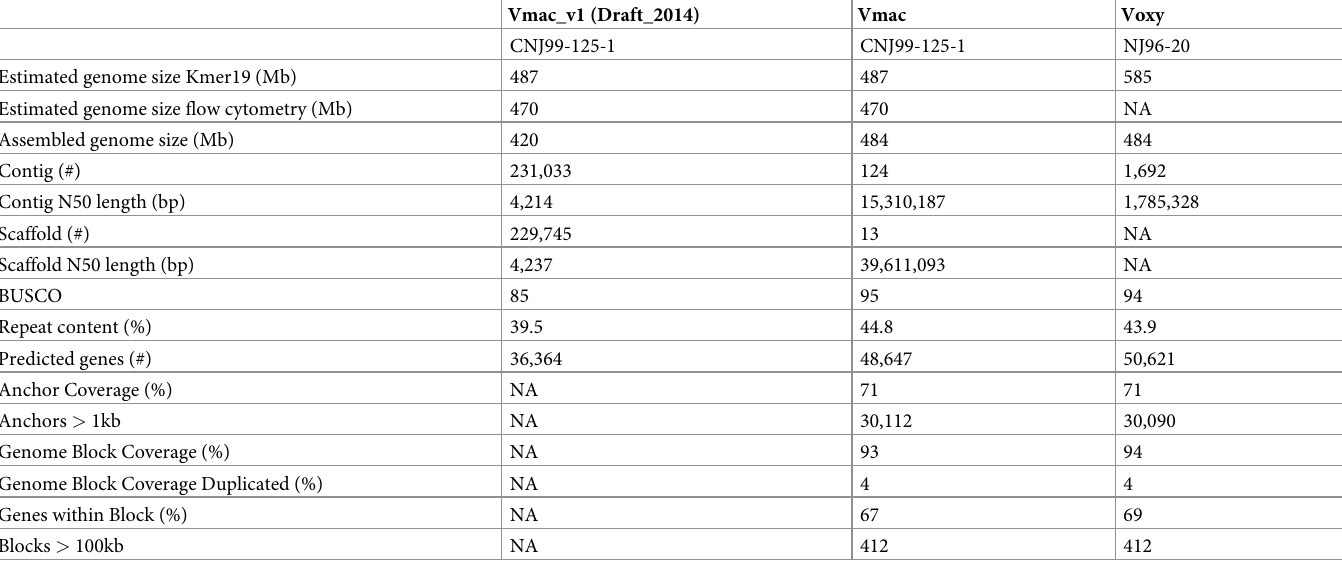
Table 1. Cranberry genome assembly statistics.